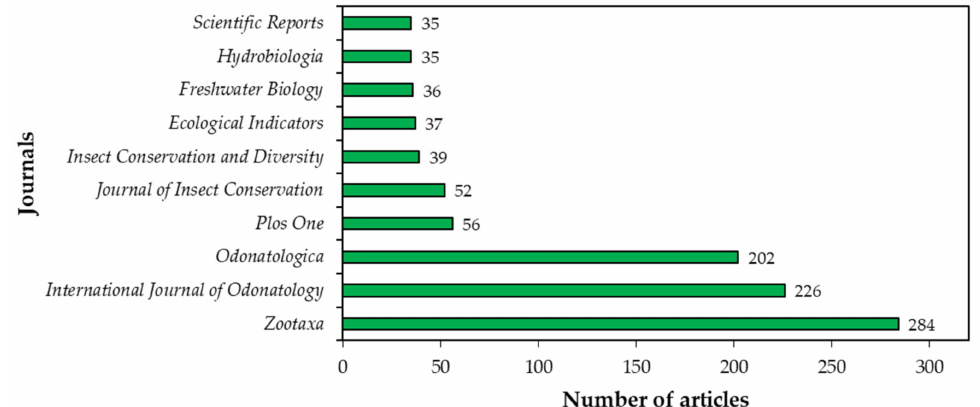
Figure 4. Scientific articles on Odonata available from the Web of Science database, per journal of publication. Plotted are the ten journals with the highest number of publications between 2012 and 2021.